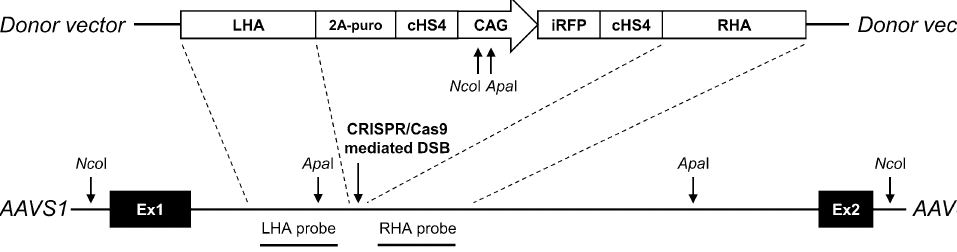
Figure 1. Targeting of the iRFP720 reporter construct into the AAVS1 locus of SBAD2 hiPSCs. Donor vector used to target the locus is depicted above. LHA/RHA: Left and Right Homology Arms, 2A-puro: 2A self- cleaving peptide sequence and the puromycin resistance gene, cHS4: chicken hypersensitive site-4 insulator sequence, CAG: CMV early enhancer/chicken β actin promoter, iRFP: iRFP720 near-infrared fluorescent protein coding sequence. The first 2 exons of PPP1R12C gene in the AAVS1 locus are shown with black boxes. CRISPR/Cas9 mediated DSB (double-strand break) and the restriction cut sites are indicated by arrows. The probes used for Southern blot analysis are depicted